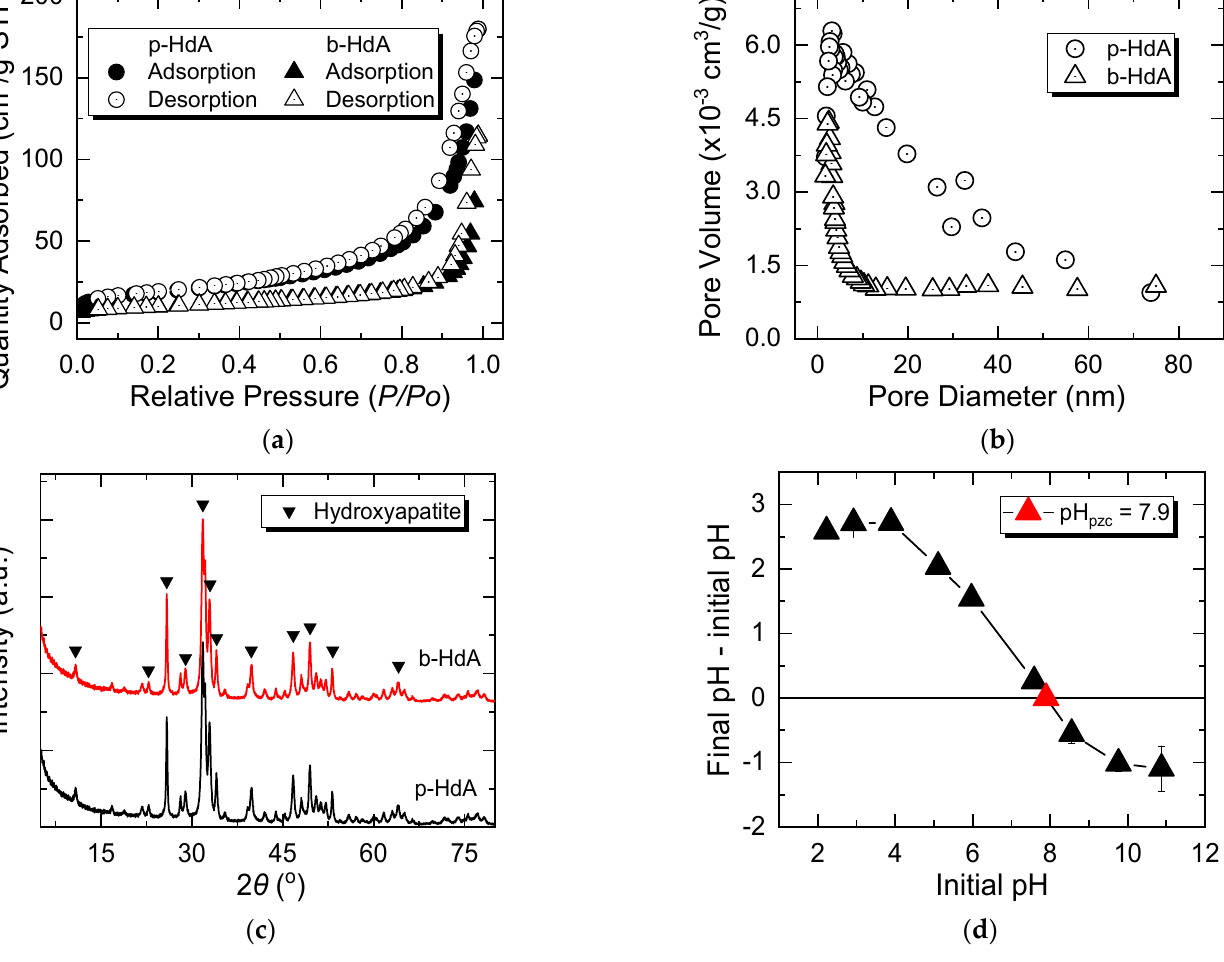
Figure 1. Typical nitrogen adsorption–desorption isotherms ( a ), pore size distribution ( b ), X-ray diffraction (XRD) patterns of the powdered HdA (p-HdA) and the porous bead form of HdA (b-HdA) ( c ), and pH pzc of b-HdA ( d ).